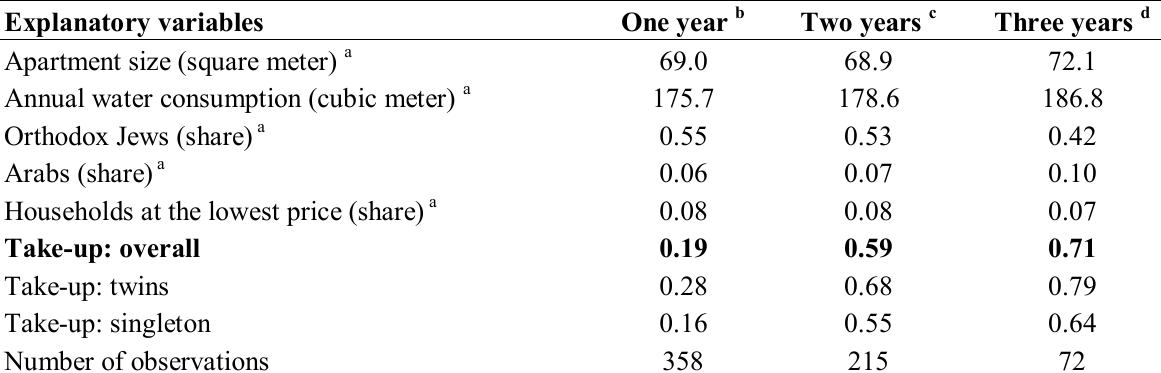
Table 2. Descriptive